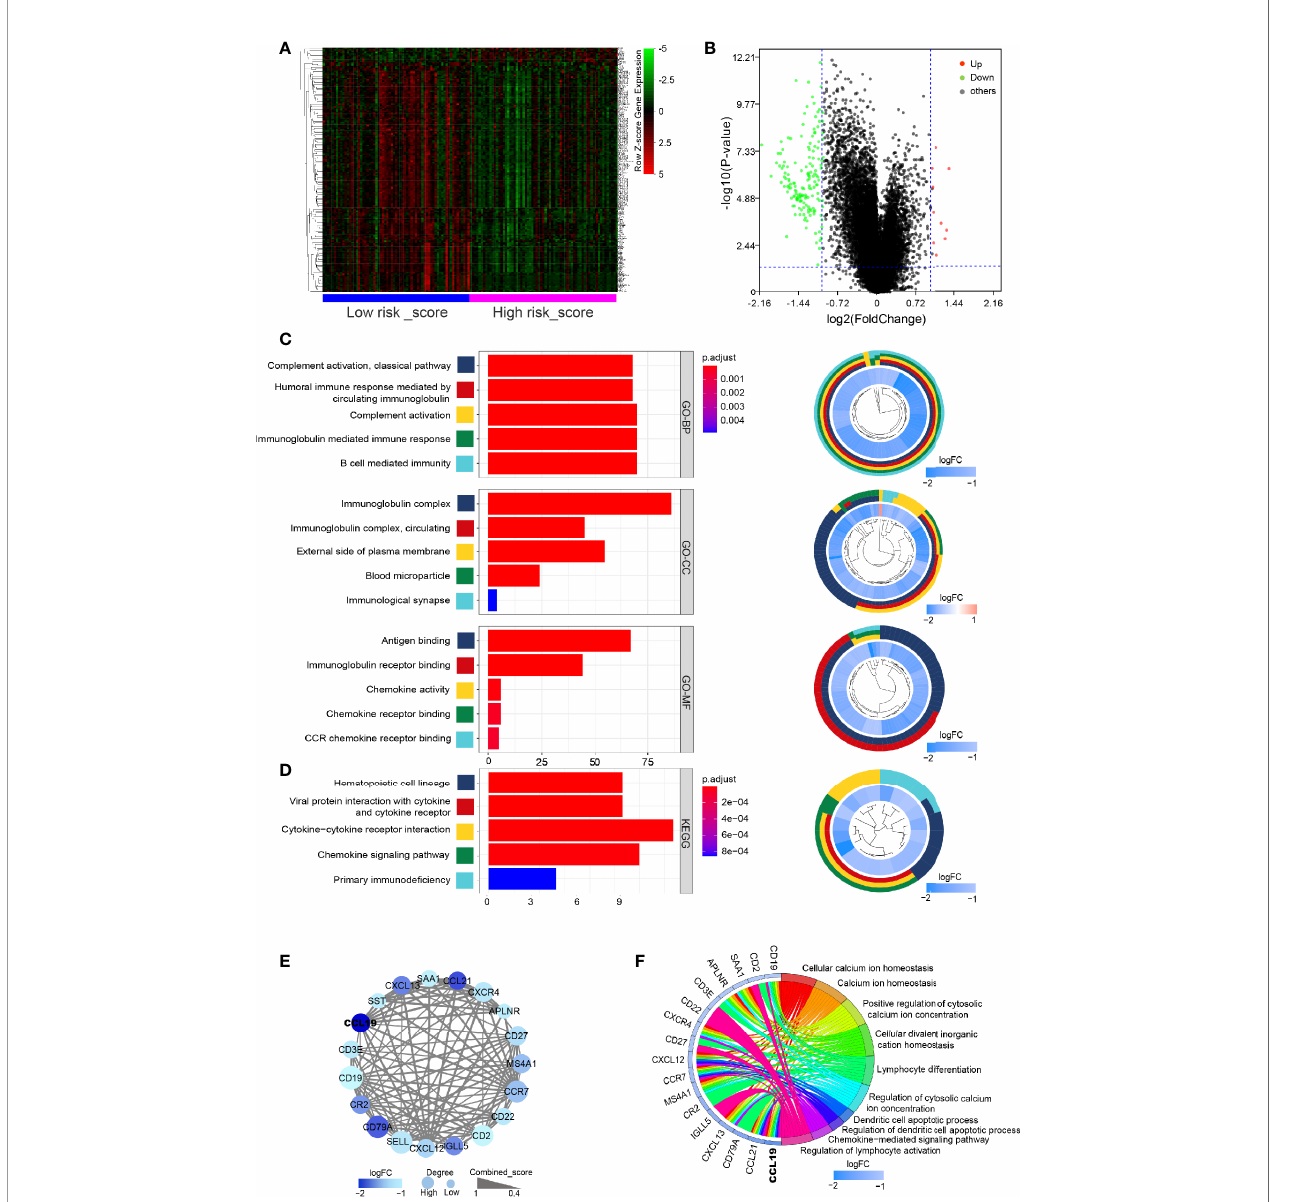
FIGURE 4 | Gene expression and function pro fi led in high and low risk-score groups. (A) Heatmap of DEGs between low risk-score and high risk-score groups. Horizontal and vertical axes represent PDAC samples and genes, respectively. Genes with higher, lower, and same expression levels are shown in red, green, and black, respectively. Color bars on bottom of the heatmap represent sample types, with blue and pink indicating low and high risk-score samples, respectively. (B) Volcano plot demonstrating the enriched genes between low risk-score and high risk-score groups. Genes expression increased in high or low risk score is shown in red or green dots, respectively (log2(fold change) > 1 and FDR < 0.05). (C, D) Bar plot for the top 5 of BP-GO terms, CC-GO terms, MF-GO terms, and KEGG analysis of DEGs. Shown on the left is cir-plot for the correlation between DEGs and GO or KEGG terms. (E) PPI network of core DEGs by